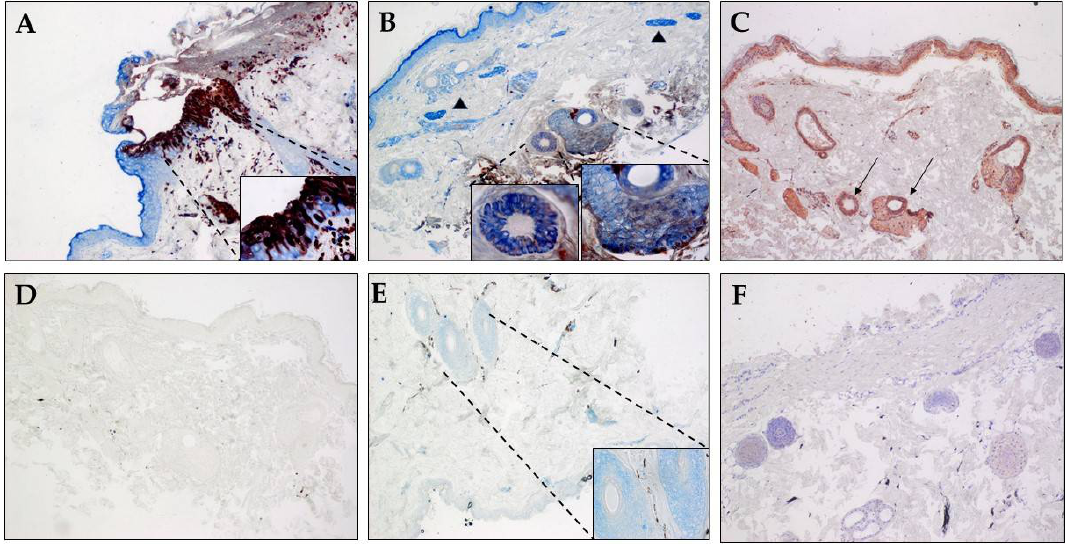
Figure 4. Colocalization of SVV antigen and β III-tubulin in skin sweat glands during zoster. Sections of biopsied, zinc-formalion-fixed, paraffin-embedded skin samples from ( A ) an acutely infected immunosuppressed rhesus macaque (B321; SVV-positive control), ( B – D ) from rhesus macaque KI92 (group 1) 91 dpx (days post-immunosuppression), and ( E , F ) an uninfected SVV-seronegative rhesus macaque (R110368) were analyzed by immunohistochemistry. Rabbit polyclonal antibodies against SVV IE63 protein (red) ( A , B , E ), SVV gH + L, and ( C ) mouse monoclonal antibody directed against human β -III tubulin (blue; A , B , E ) were used as described in methods. Nerve bundles containing β III-tubulin are identified by arrowheads in panel B. Normal rabbit serum by itself ( F ) or with mouse anti IgG2a antibody ( D ) were used as negative controls. Colocalization of SVV IE63 protein with β -III tubulin can be seen in epidermis during acute infection ( A , inset) and in sweat glands and hair follicles during reactivation ( B , inset). SVV gH + L antigens can also be seen in sweat glands in an adjacent section ( C , thin arrows). β -III tubulin, but not SVV IE63, protein can be seen in sweat glands and hair follicle in skin from an uninfected monkey ( E , inset). Normal rabbit serum along with mouse anti IgG2a antibody on skin from zoster in monkey KI92 ( D ) or using rabbit anti SVV gH + L on skin section from the uninfected monkey ( F ) did not show any staining. Section in panel F was counterstained with hematoxylin. (Magnification, × 100, inset ×